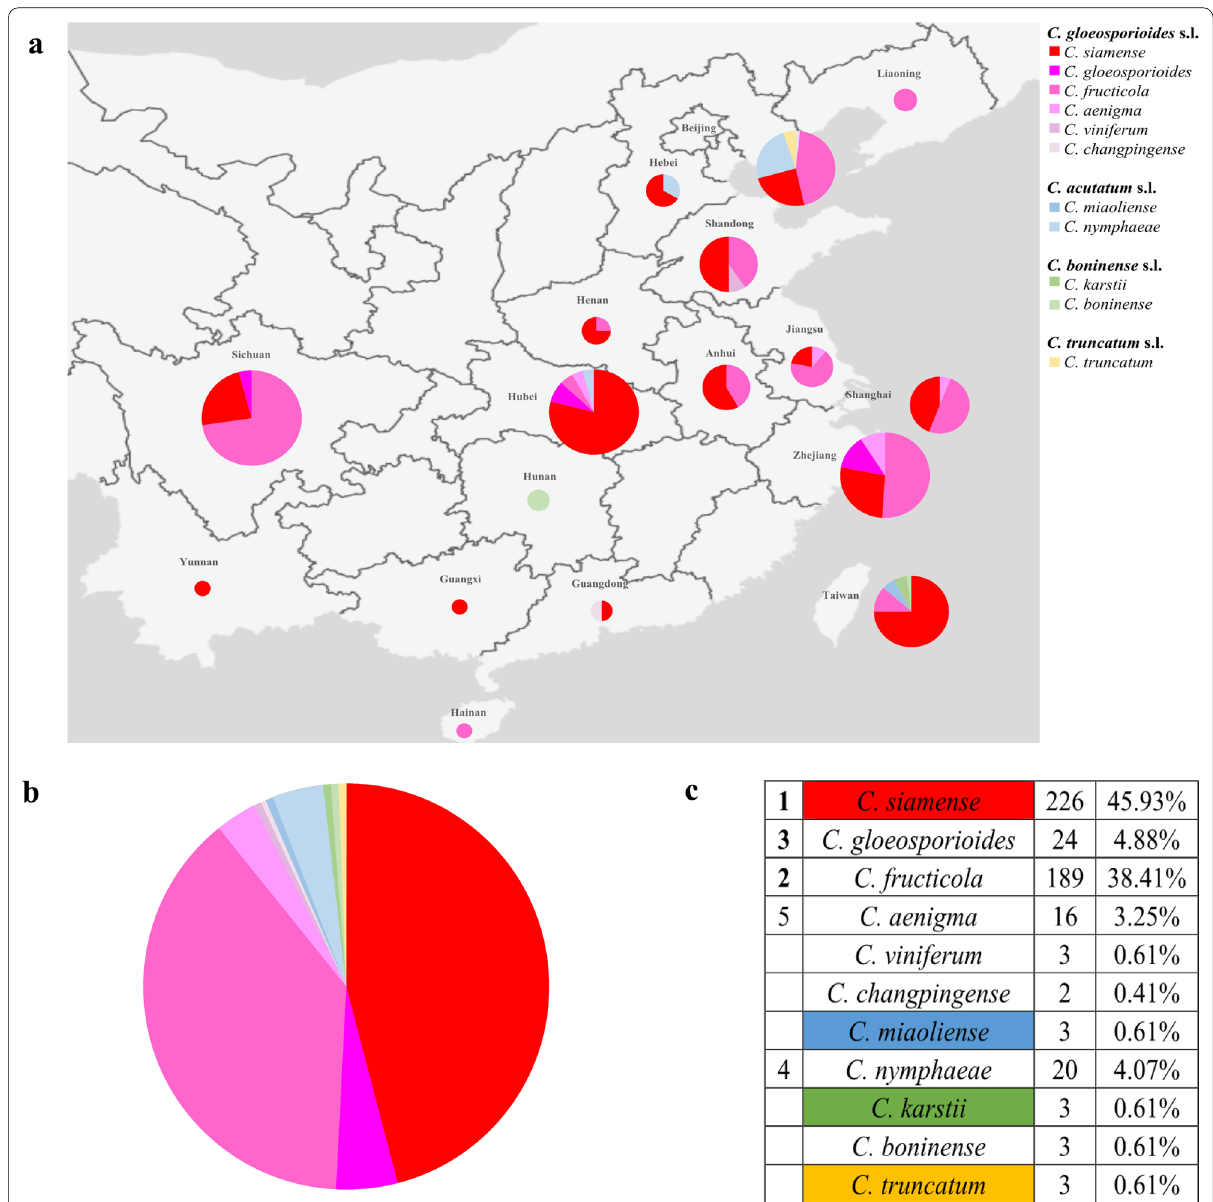
Fig. 3 Diversity and prevalence of Colletotrichum species infectious to strawberry in China. a The population structure and geographical distribution of strawberry anthracnose pathogens. Different colors are used to distinguish species complexes: reds for C. gloeosporioides , blues for C. acutatum , greens for C. boninense , and yellow for C. truncatum . Pie charts were generated with log‑10 transformed numbers of fungal isolates in certain region obtained from 11 publications since 2016 (Han et al. 2016; Jayawardena et al. 2016a; Bi et al. 2017a, b; He et al. 2019; Chen et